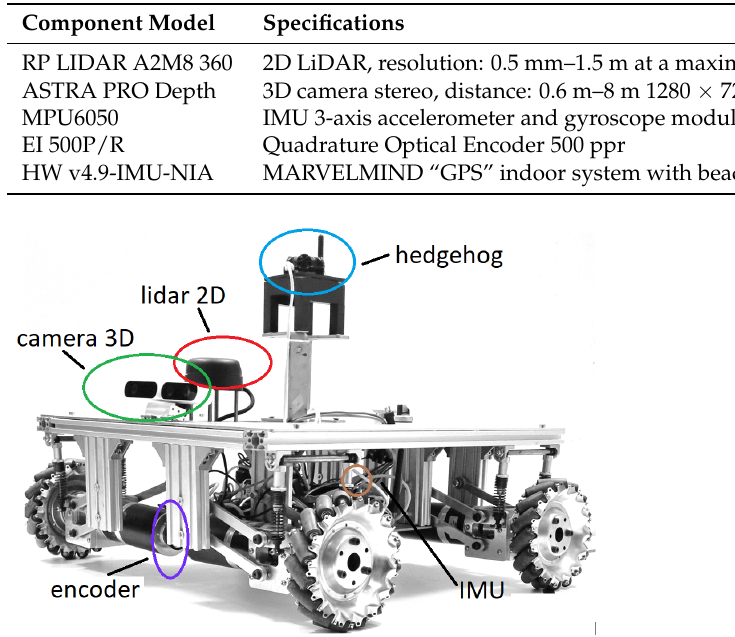
Figure 1. The OMR used in the experiments.